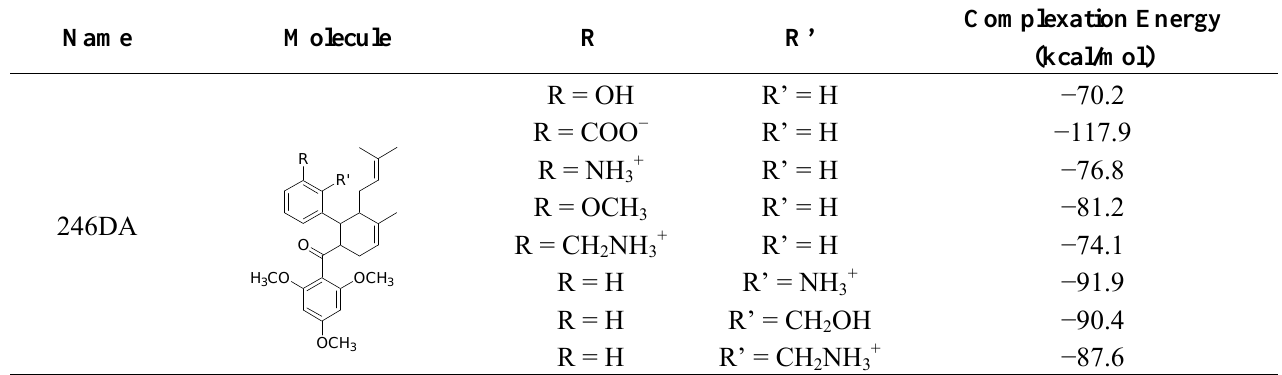
Table 5. Some 246DA, 20H46DA derivative substitutions at the 4 and 5 positions and 2446DA derivative substitutions at the 3 and 4 positions of benzyl ring A (R and R’ positions